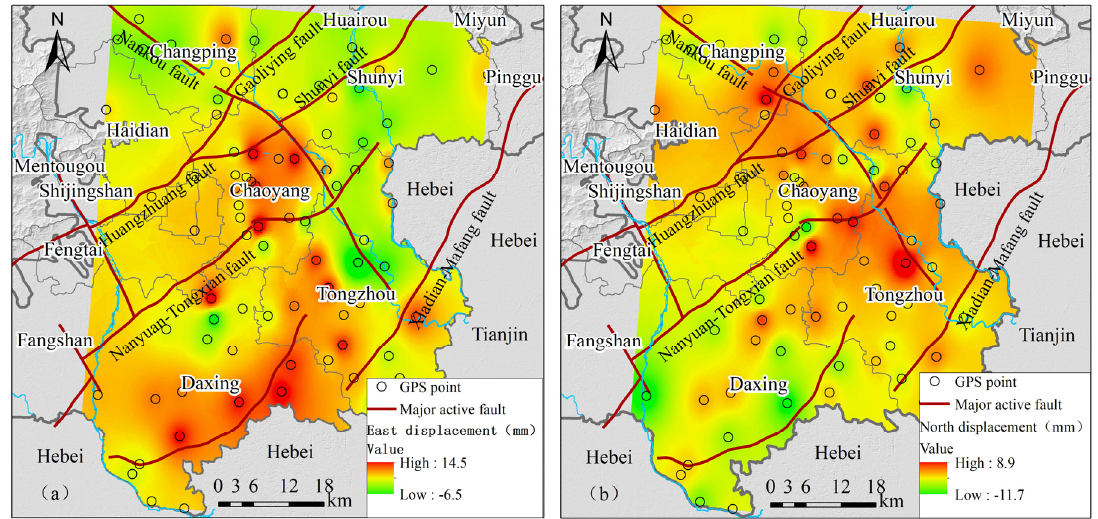
Figure 12. The main faults and the horizontal velocity obtained by GPS interpolation under the Eurasian Reference Frame (2013~2018). (a) E-W deformation. (b) S-N deformation.